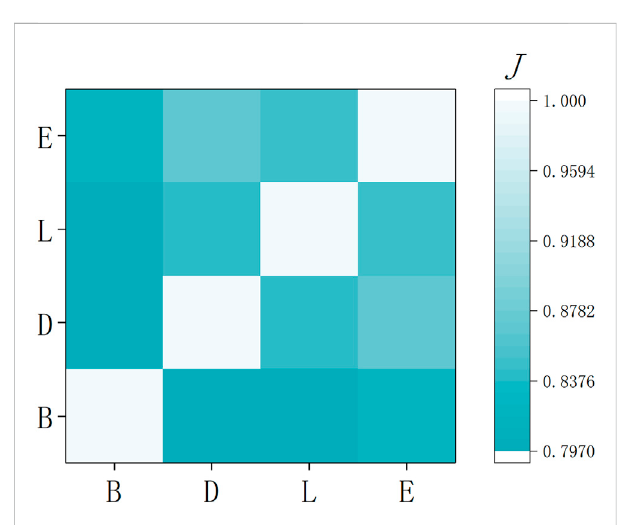
FIGURE 9 Thecorrelationheatmapforthefourindicesofedgeimportance overBAnetwork.Here,B,D,LandErepresentABC,ADCM,LIand E BD ,